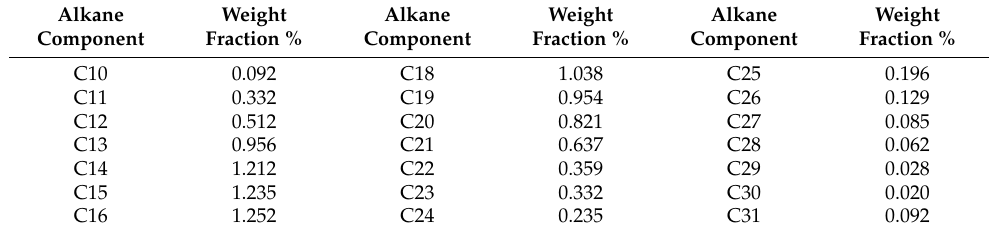
Figure 13. The weight percent ratio of each carbon number in precipitated wax at different temperatures of 20% artificial oil.